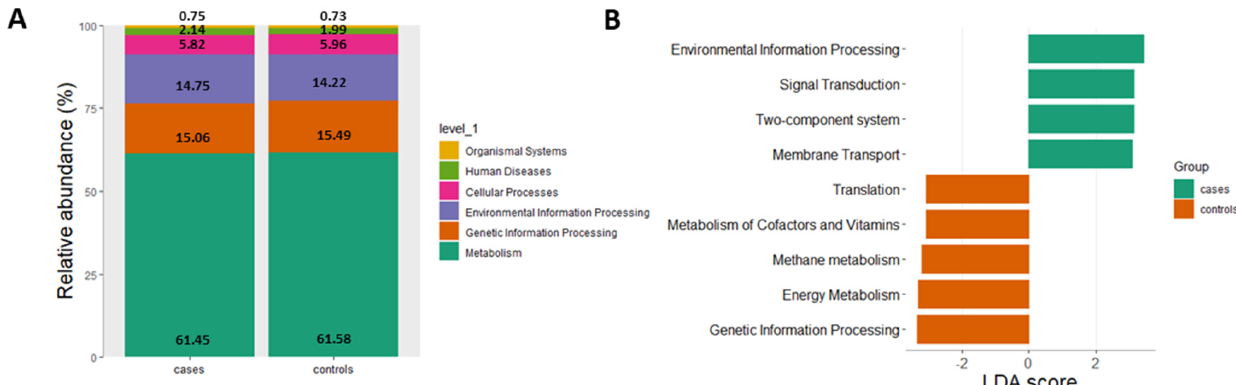
Figure 5. Results of the relative abundance (in %) of level 1 ( A ) functional pathways and ( B ) linear discriminant analysis (LDA) effect size (LEfSe) plot of functional pathways identified in the gut microbiomes of cases and controls. The threshold for the logarithmic discriminant analysis (LDA) score was 3 ( p < 5 × 10 − 2 ). Figures and calculations were assessed by the “microeco” package (version 0.4.0) with the “Tax4Fun” package included in RStudio (version 0.3.1).